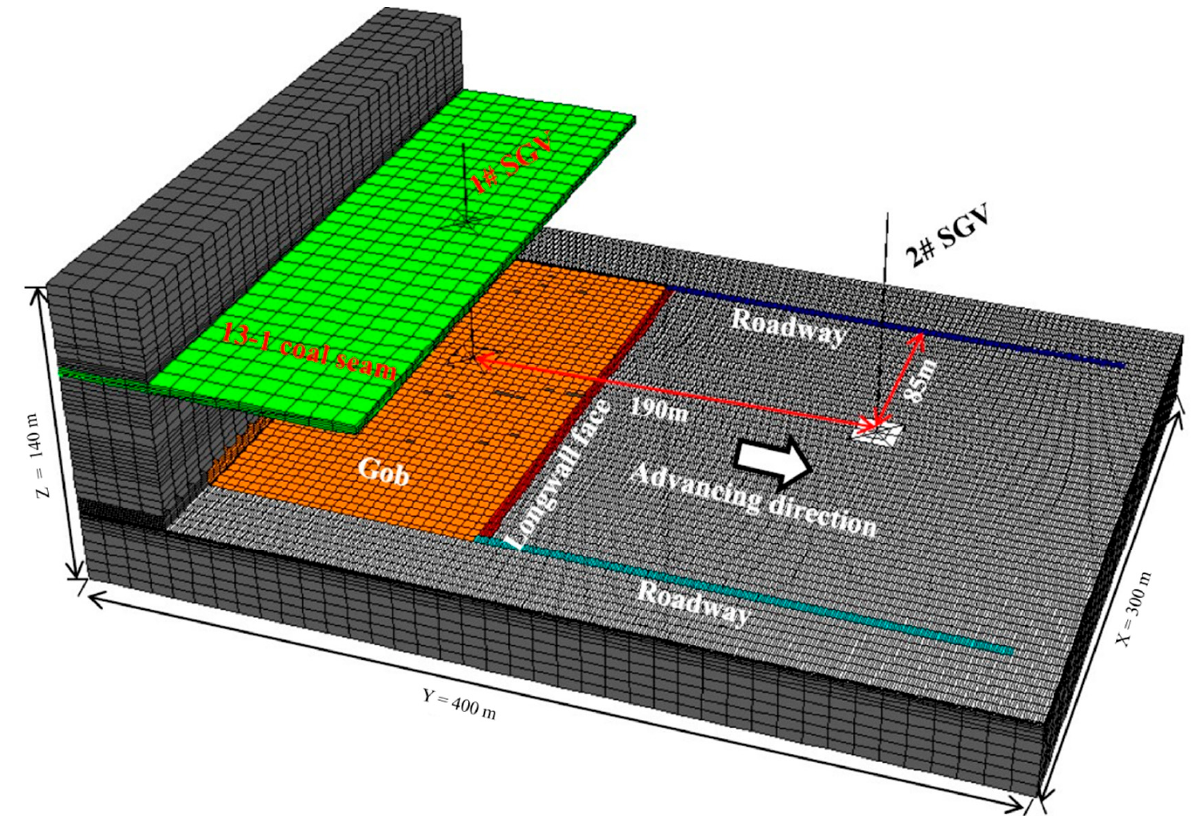
Figure 4. Numerical model of longwall face 1242(1) [34].